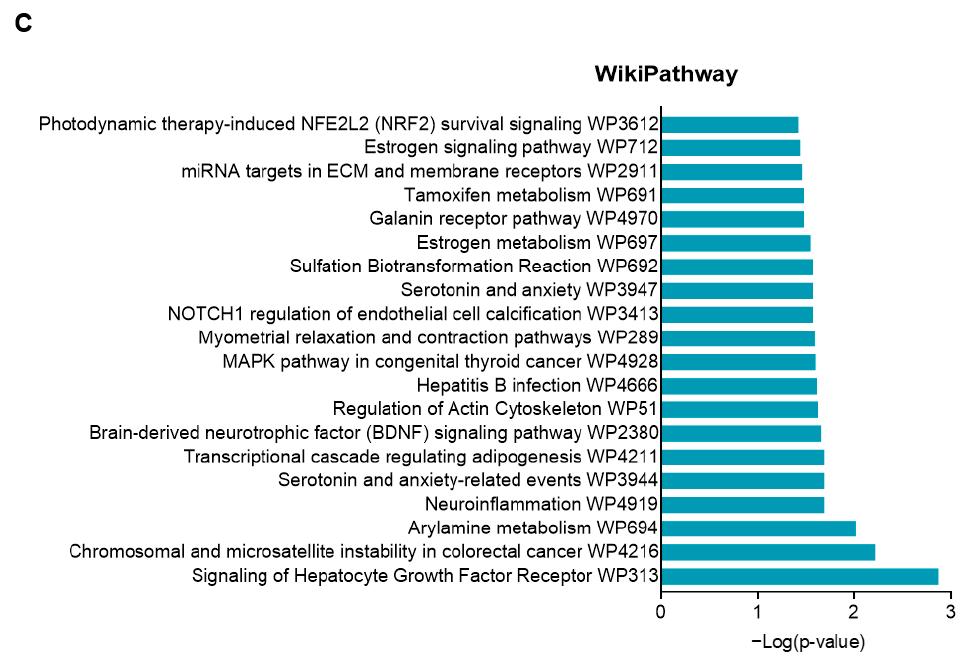
Figure 6. Effects of CIEO on gene expression in the hippocampus. ( A ) Heatmap representing the relative expression of DEGs in the hippocampus between the CON group and the CIEO group. ( B ) GO Biological Process enrichment of DEGs. ( C ) WikiPathway enrichment analysis of DEGs. DEG: differentially expressed genes; GO: Gene Ontology.